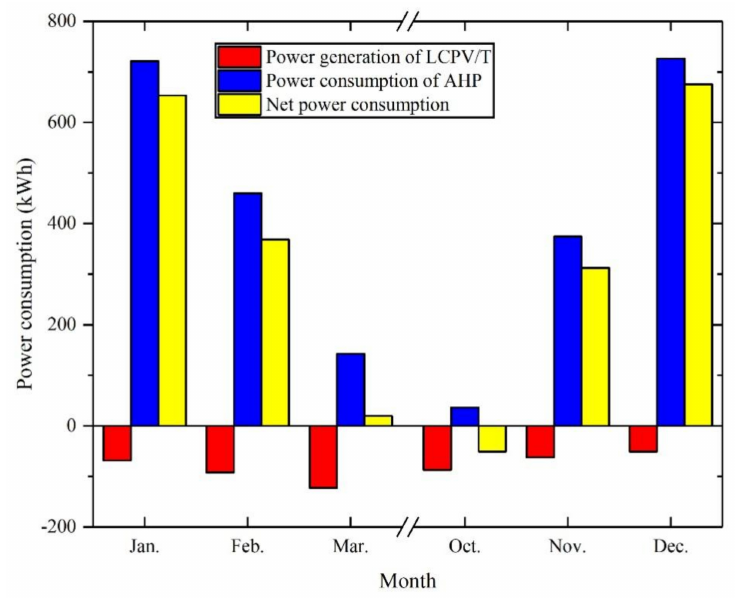
Figure 15. Annual power generation and consumption of the LCPV/T-AHP system.